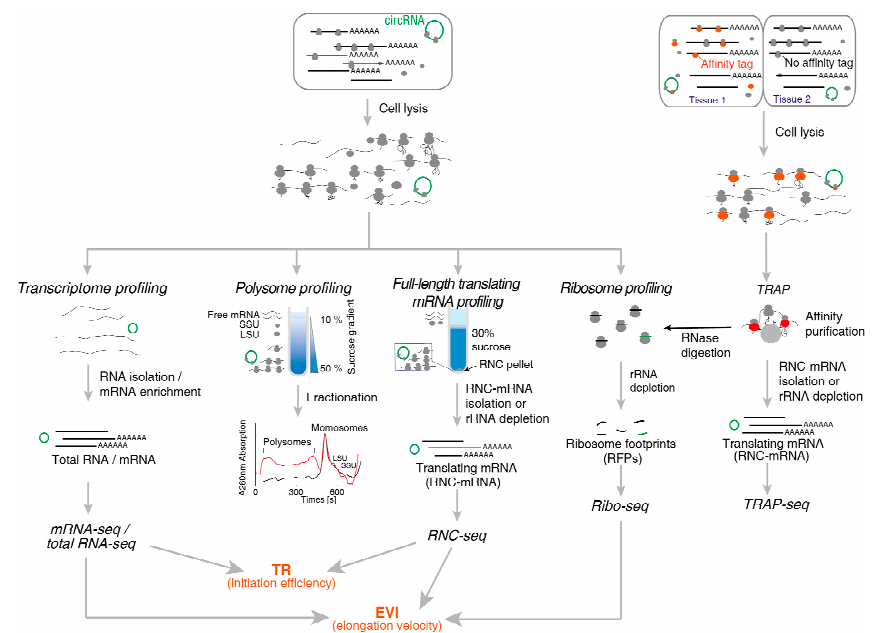
Figure 1. The major translatomic methods which investigate translating RNAs.